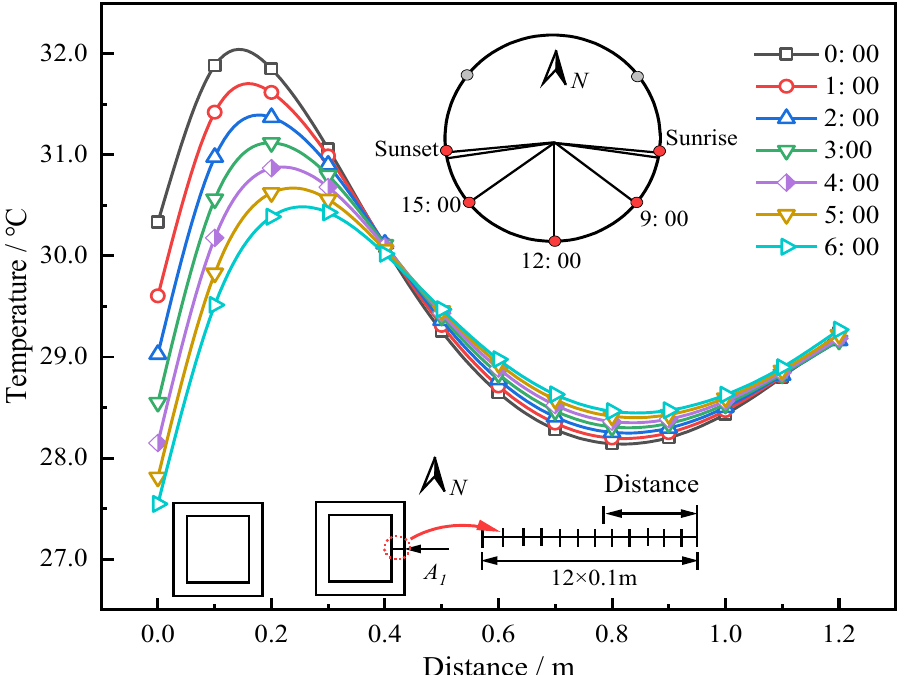
Figure 22. The temperature change curve in the thickness direction of the east tower wall at a 125 m height in the early morning.